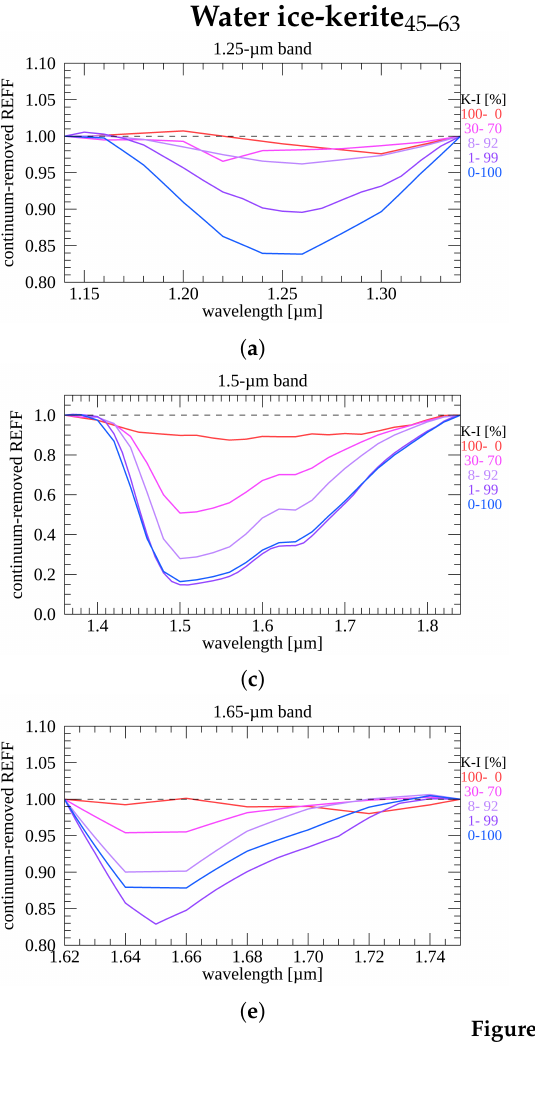
Figure 3. REFF spectra for water ice–kerite 45–63 ( left panels) and water ice–kerite < 25 ( right panels) intimate mixtures. Mass fractions are indicated (K: kerite, I: water ice). Panels ( c , d ) show zooms of ( a , b ), respectively, at IR wavelengths and low reflectances. The light gray bands indicate a spectral region where possible residual water vapour contamination in the optical path may affect the resulting spectra.